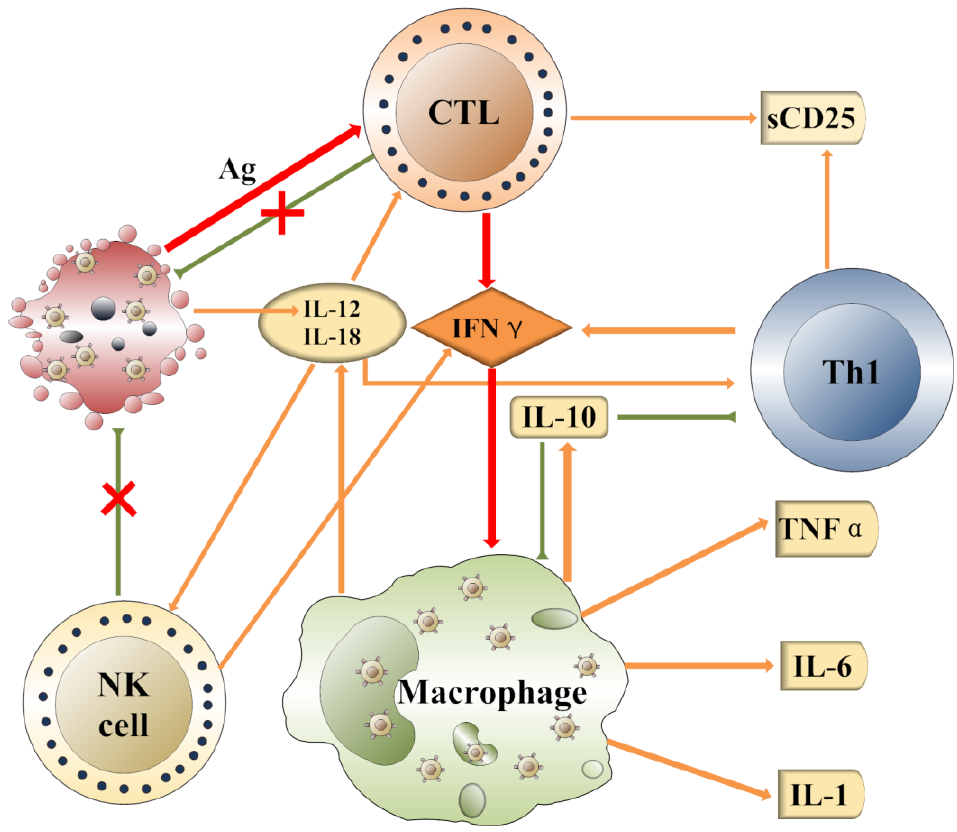
FIGURE 2. The proposed network of cytokine regulation associated with the pathophysiology of HLH. Pathogenic viral infection in a normal individual leads to the production of proinflammatory factors, such as IL-12, by the infected cells. This induces relevant responses from NK cells and lymphocytes. Once induced, NK cell and CTL cytotoxicity can help to rapidly eliminate the infected cells and serves to prevent further immune-cell activation. In HLH patients, the NK cells and CTLs fail to lyse the infected cells. Thus, the inflammatory response continues unabated. T cells continue to proliferate and to produce a great quantity of IFN-γ, stimulating the macrophage uncontrolled activation in turn, secreting high levels of IL-12 and other cytokines, such as IL-1, IL-6, IL-10, IL-18, and TNF- α. IL-12 functions to stimulate CTLs to expand and to produce IFN-γ. The hypercytokinemia leads to the accumulation of lymphohistiocytic infiltrates into organs and organ damage.